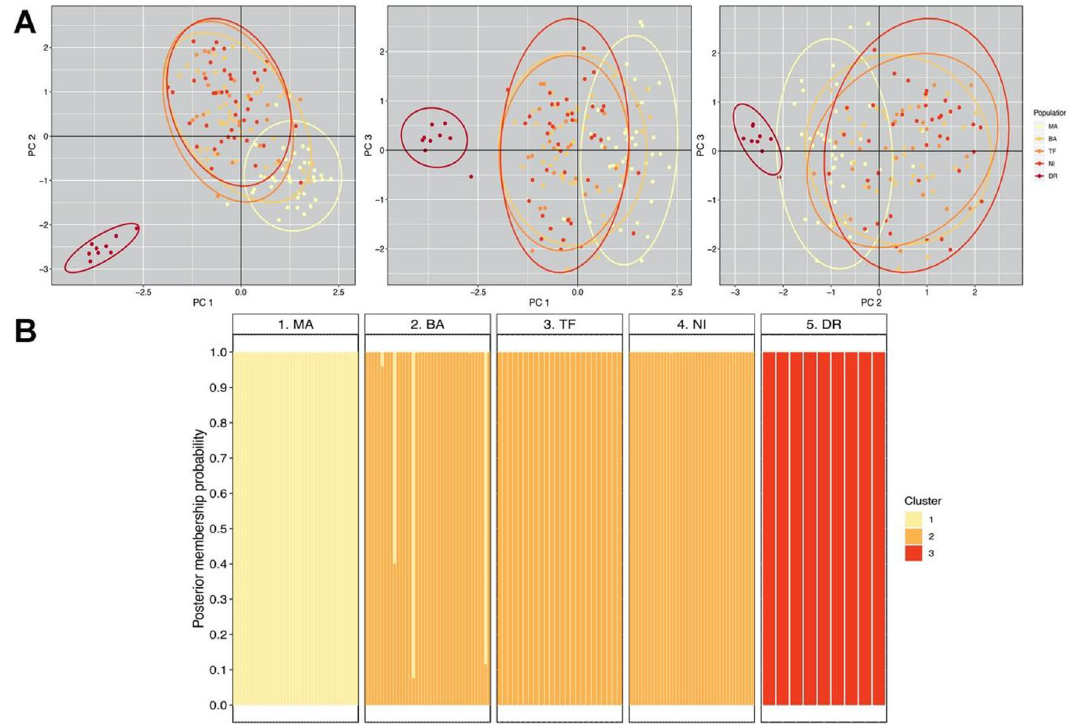
Figure 6. Genetic variation among five populations of Aphrastura , based on 153 individuals genotyped at 12 polymorphic microsatellite loci. ( A ) Scatterplot from the first three principal components that explained 25.5% of the genetic variance. 95% CI ellipses are shown. ( B ) Individual assignment to genetic clusters for the five sampled populations. Bars represent individual posterior membership probabilities to each of the three genetic clusters found using the ‘snapclust’ method. MA Manquehue, BA Bariloche, TF Tierra del Fuego, NI Navarino Island, DR Diego Ramírez (representing the proposed new species A. subantarctica ) . Genetic cluster